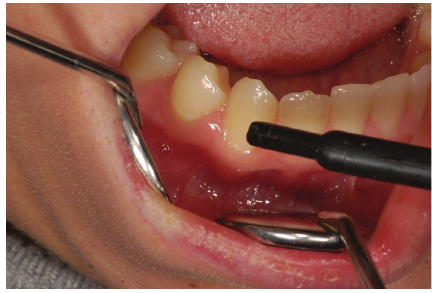
Figure 1: Air stimulus application.